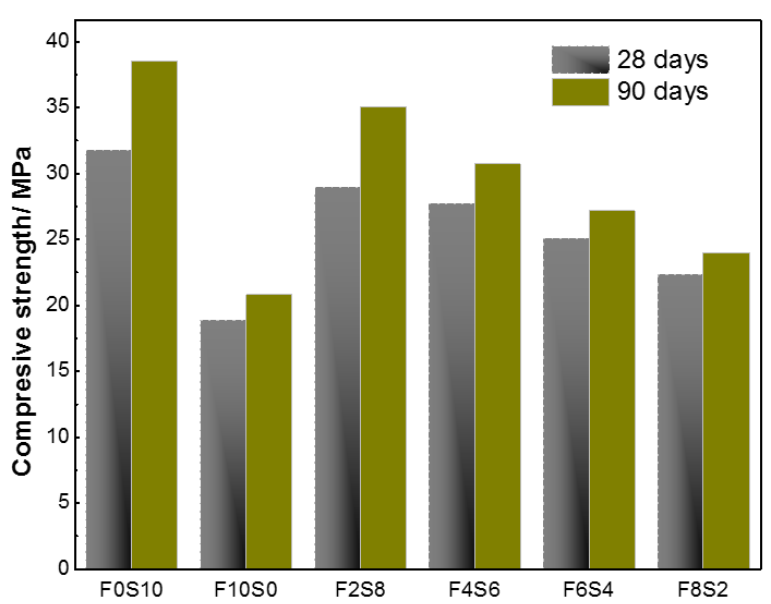
Figure 6. Compression strength development of alkali-activated slag/fly ash concretes over time.